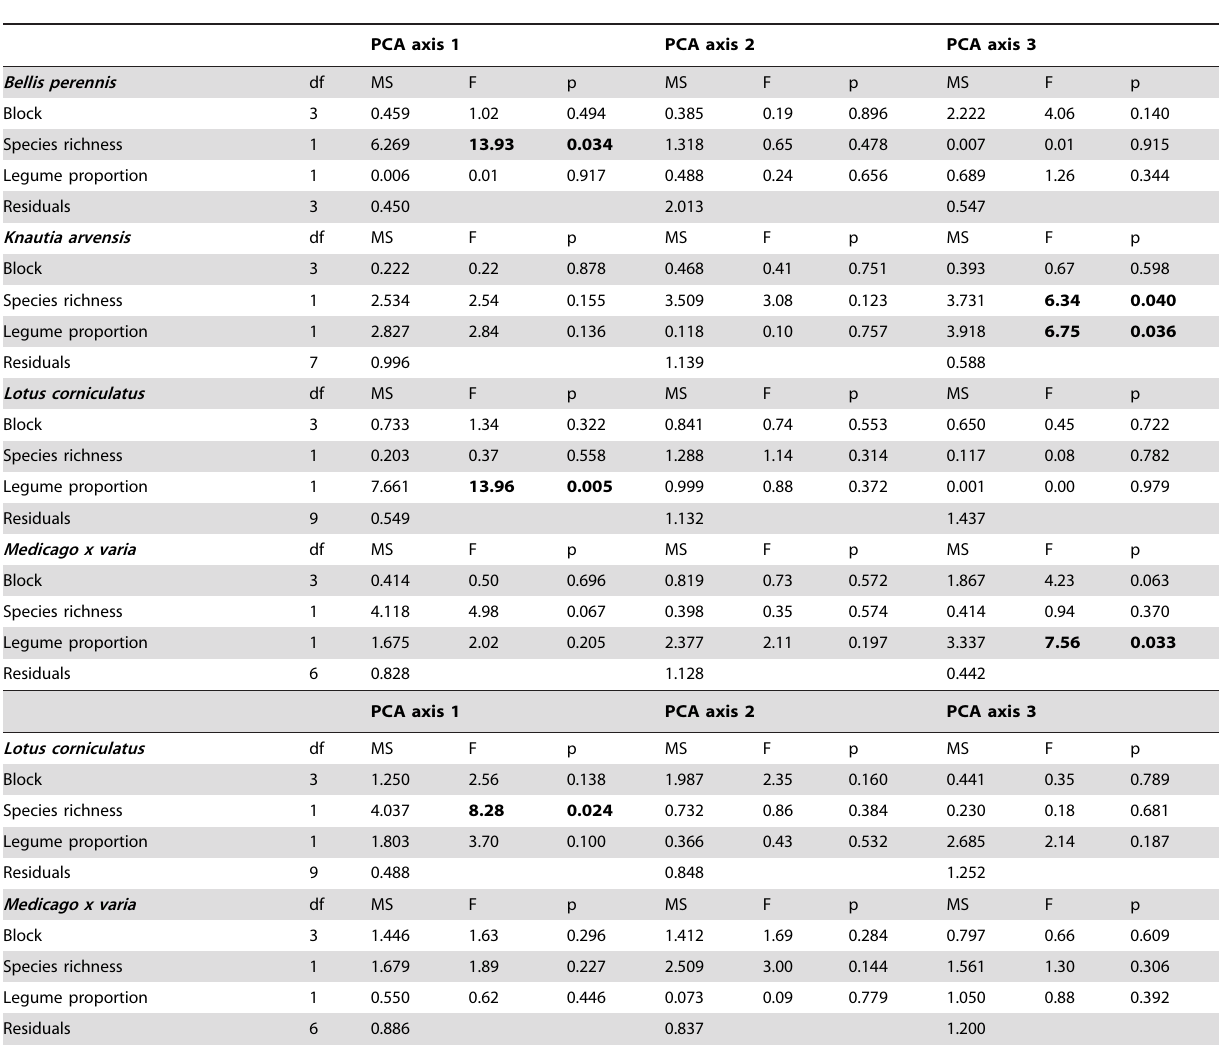
Summary of analyses of variance (ANOVA) on the sample scores of the two leading axes of a standardized principal components analysis (PCA) of GC-TOF-MS and LC-FT- MS data (Fig. S1 and S2). Block identity, sown species richness (as log-linear term) and legume proportions (ranging from 0 when legumes were absent to 1 for pure legume communities) were fitted sequentially (type I sums of squares). Abbreviations are: df=degrees of freedom, MS=mean squares, F=F values, p=p values; significant effects are given in